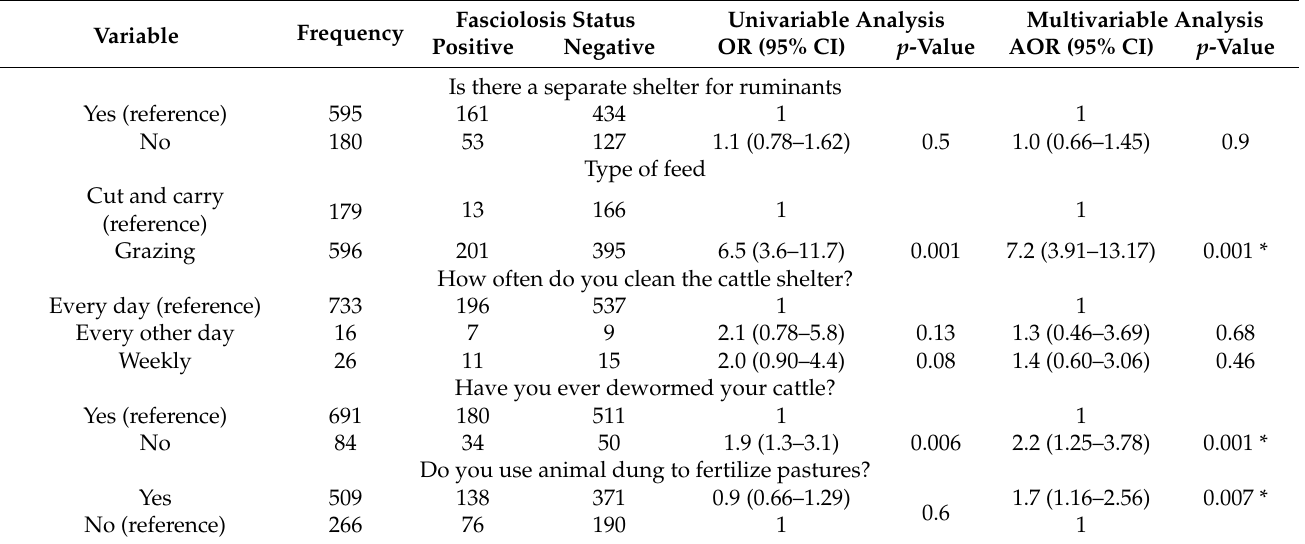
Table 6. Factors associated with fasciolosis status in animals in the Butajira and Gilgel Gibe HDSS sites,